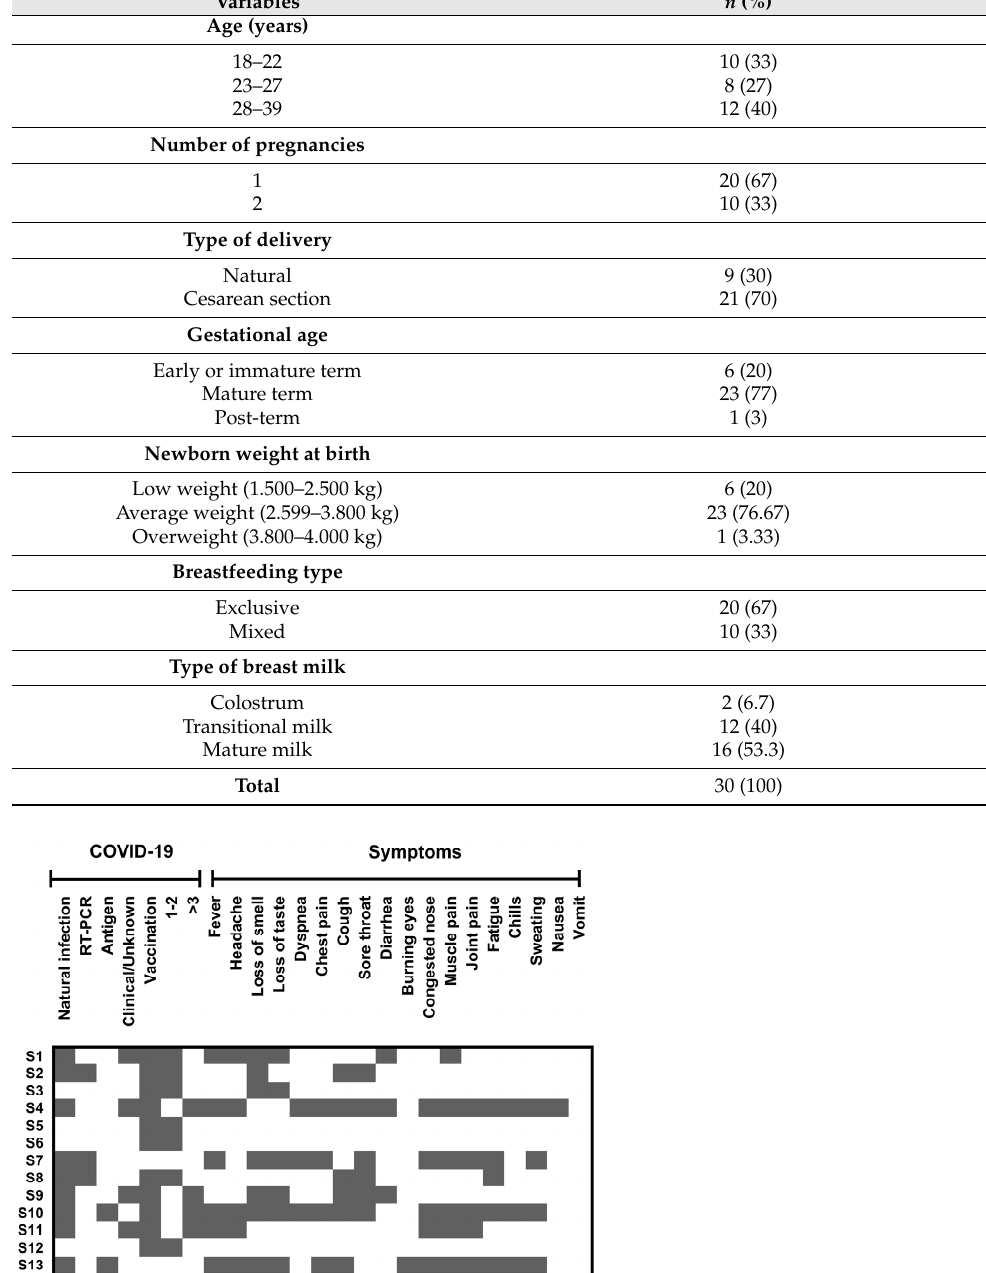
Table 1. Characteristics of the studied population.